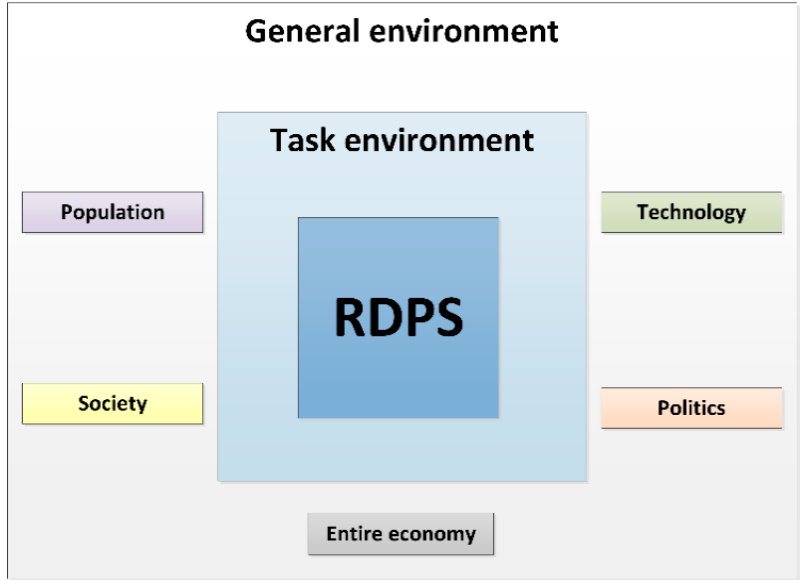
Figure 3. RDPS environmental analysis.